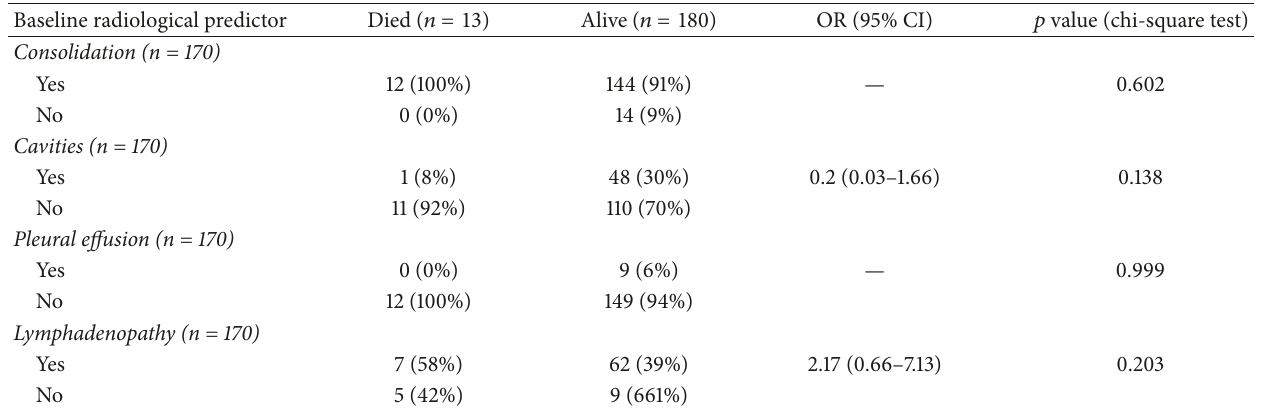
Table 5: Radiological predictors of MDRTB